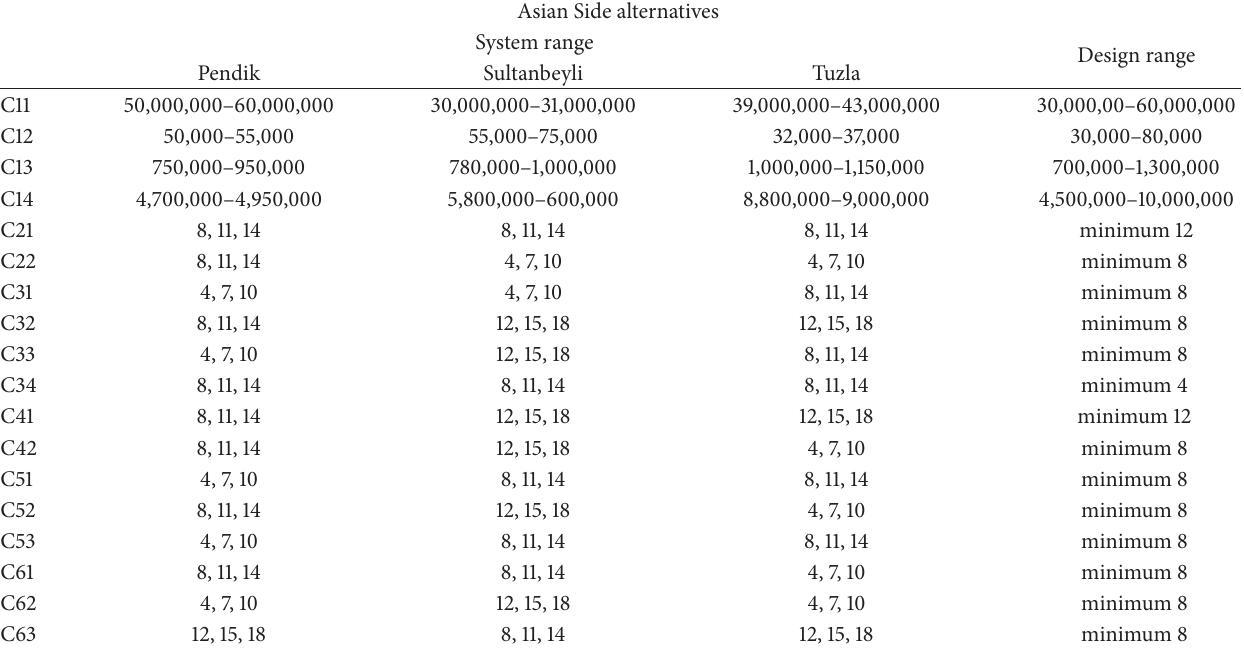
Table 7: The system and design range for Asian Side of Istanbul.